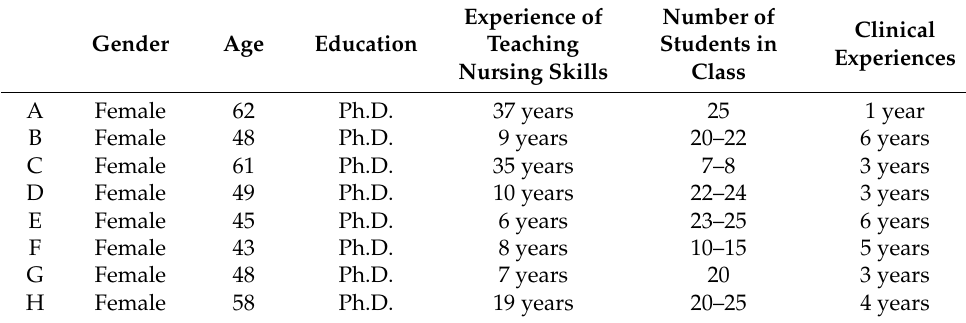
Table 1. General Characteristics of